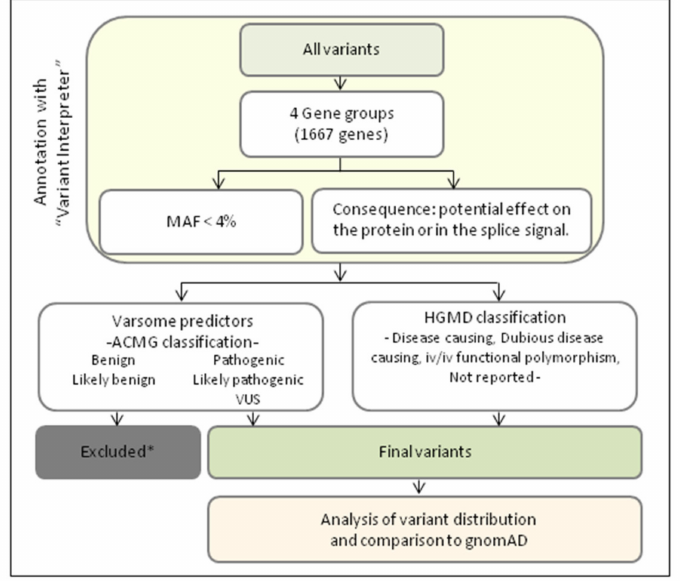
Figure 1. Flowchart of the analytical strategy used in this study. * Except those variants classified in the HGMD as disease causing, dubious disease causing or iv/iv functional